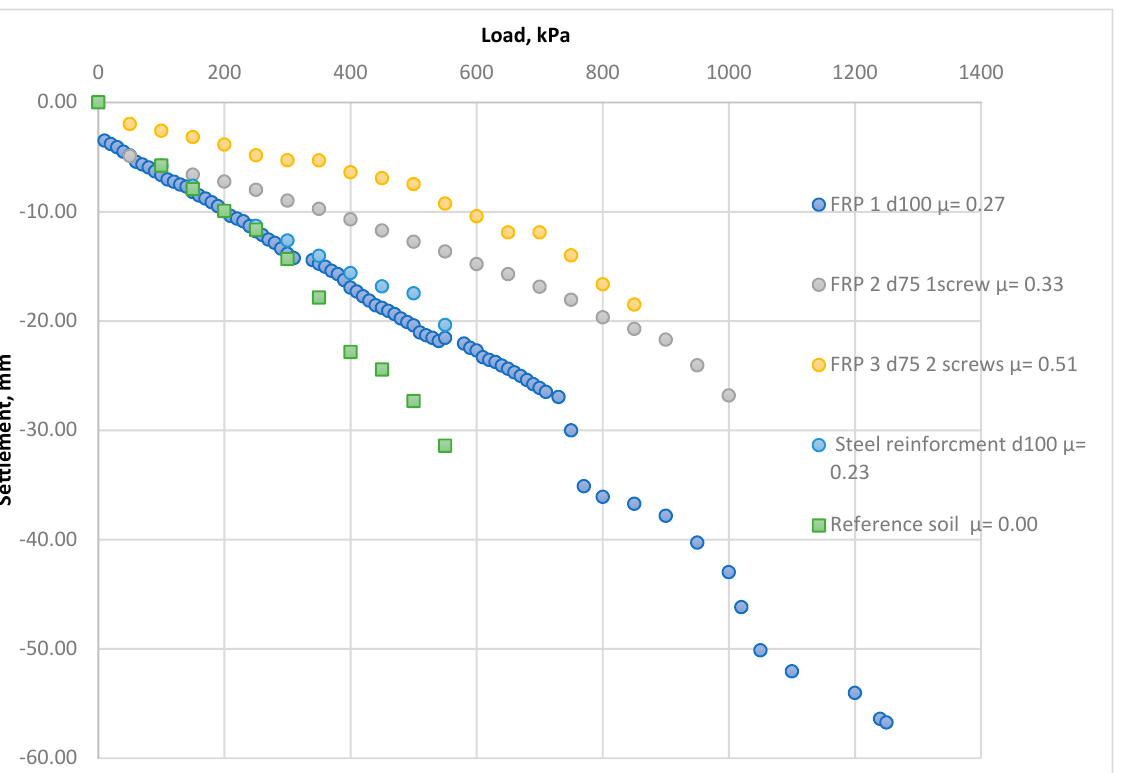
Table 2. Summary of the in-situ deformation modulus before and after the reinforcement.